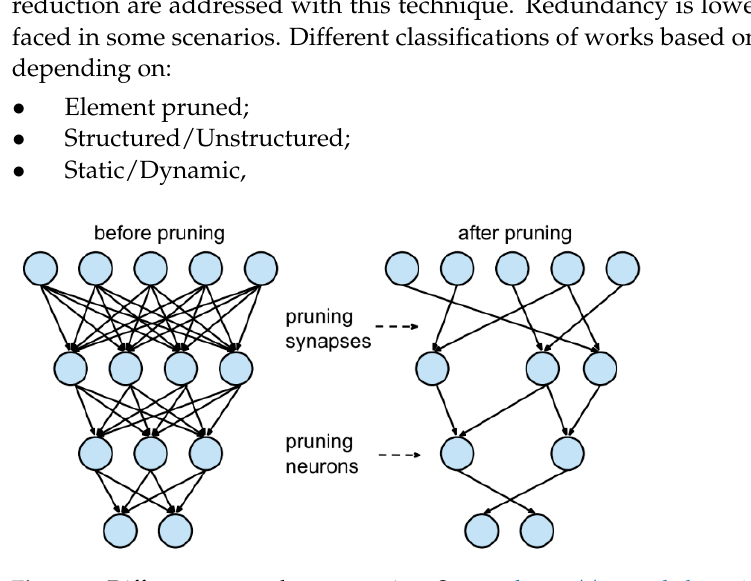
Figure 1. Different approaches to pruning. Source: https://towardsdatascience.com/pruning-deep- neural-network-56cae1ec5505 (accessed on 20 July neural-network-56cae1ec5505 (accessed on 20 July 2022).